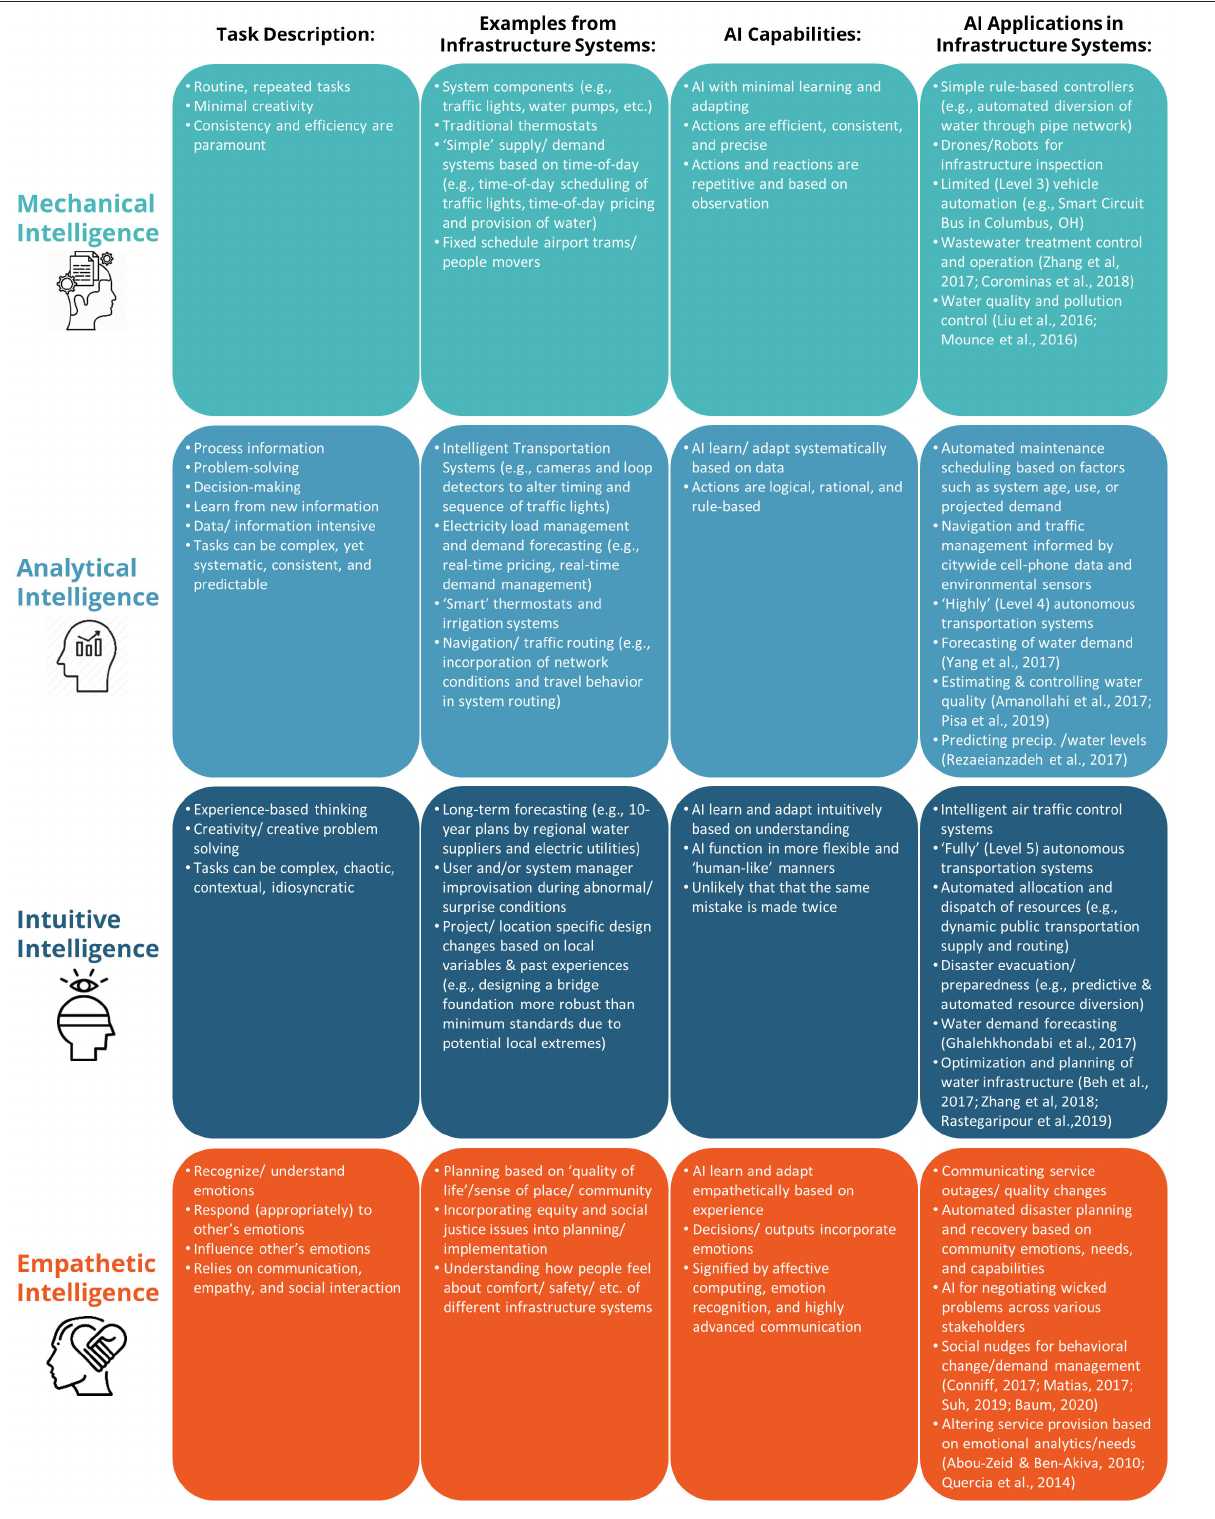
Frontiers in Water |